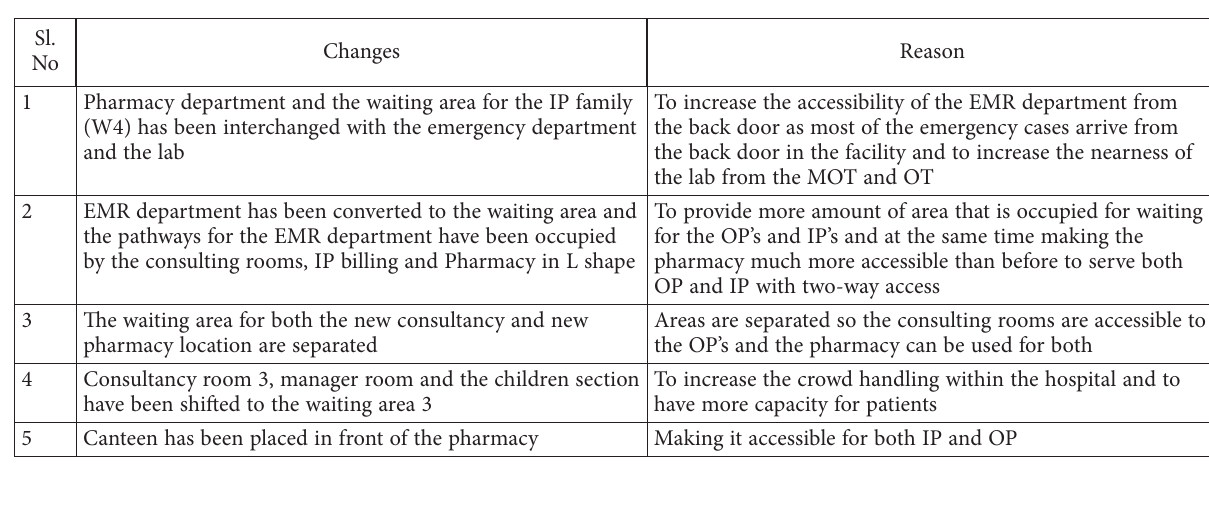
Table 5. Changes made in Plan 4 and reasons